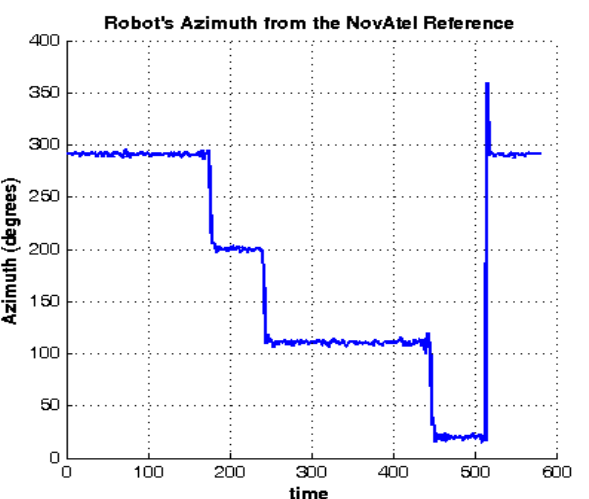
Figure 12. Mobile Robot Dynamics (Azimuth and Horizontal Speed) over Trajectory (1) from the